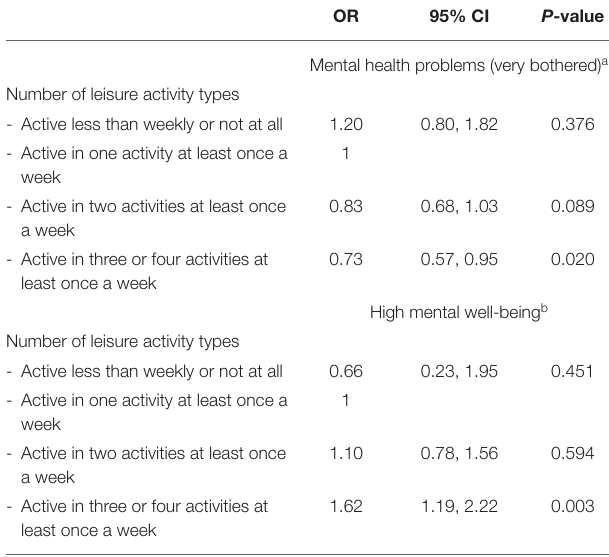
TABLE 3 | The association between number of leisure activity types and mental health estimated by multivariable logistic regression. OR 95% CI P -value Mental health problems (very bothered)